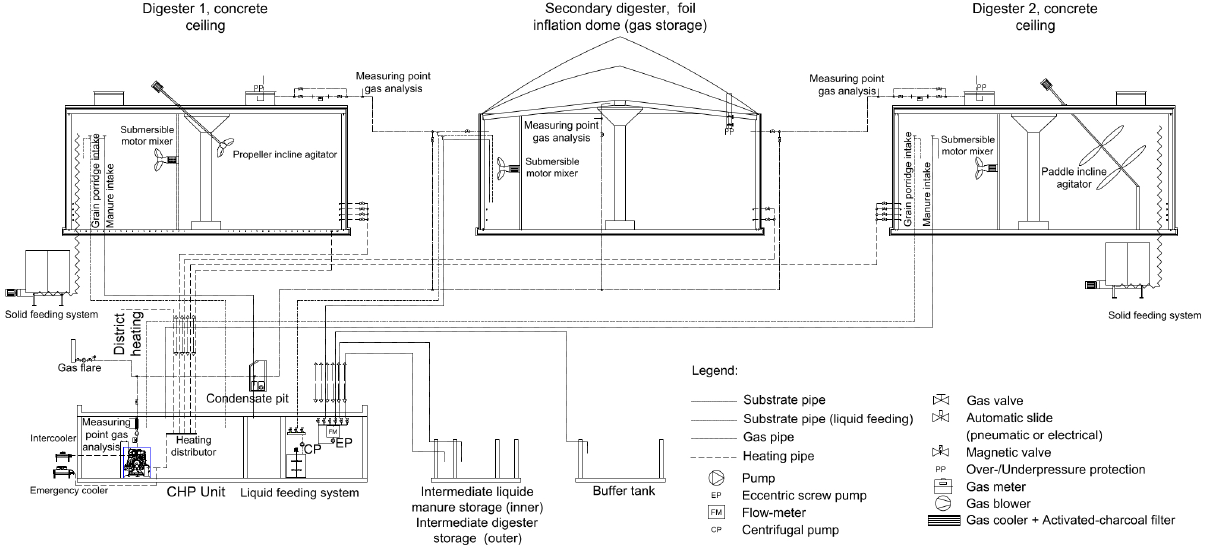
Figure 2. Flow scheme of the investigated research biogas plant